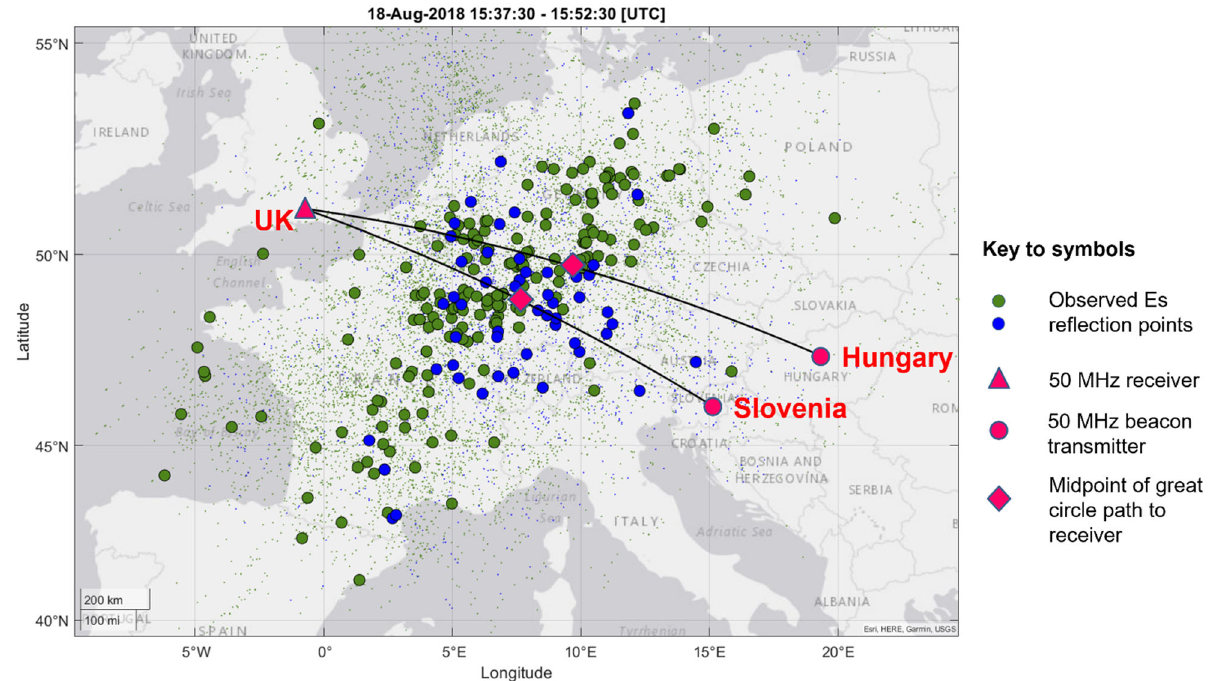
Figure 12. Sporadic-E observed over western Europe 18 August 2018 15:37:30–15:52:30 UTC, mapped using amateur radio signal reports. Slovenia and Hungary beacons and UK receiving location marked. Black lines: great circle paths from beacons to receiver with midpoints indicated. Note that magnetic north is within 2° of geographical north in this part of Europe. Adapted from [42].